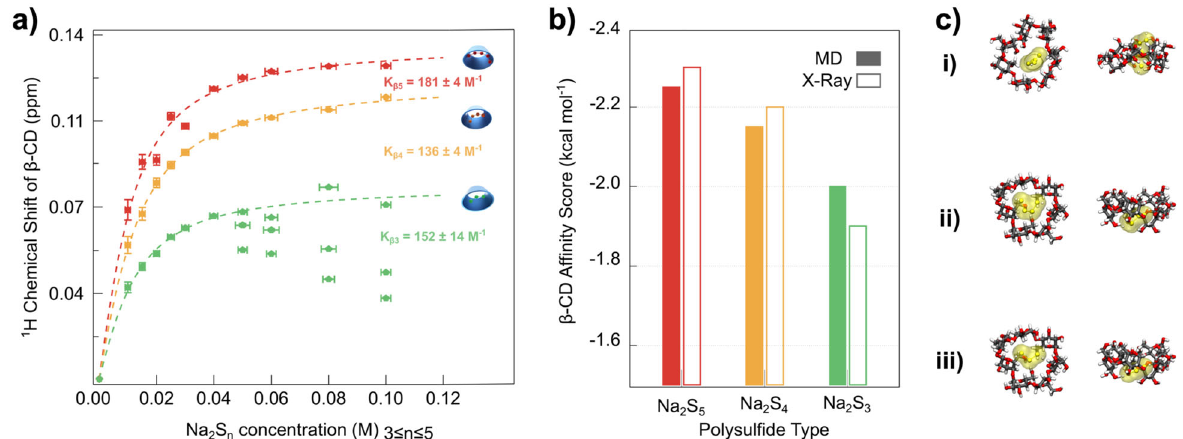
Fig. 3 In fl uence of polysul fi des chain length on β -cyclodextrin complexation. a Experimental binding isotherms for β -cyclodextrin complexes with Na 2 S 5 (red), Na 2 S 4 (orange), Na 2 S 3 (green), (See “ Methods ” section). The statistic error relative to the chemical shift measurement was obtained by the calculation of the standard deviation of 10 similar and independent points and is estimated to 9%. The plotted error bars were calculated considering the uncertainties propagation (see “ Methods ” section). b Best docking af fi nity scores (kcal mol − 1 ) over all the calculated β -cyclodextrin inclusion complexes with Na 2 S 5 (red), Na 2 S 4 (orange), and Na 2 S 3 (green). The fi rst set of calculations used the cyclodextrin structures extracted from PDB as receptors (empty bars) and the second set used the cyclodextrin structures generated by Molecular Dynamics simulations (full bars) (See “ Methods ” section and Supplementary Fig. 4). c Corresponding best docking poses for (i) Na 2 S 5 / β -cyclodextrin, (ii) Na 2 S 4 / β -cyclodextrin, and (iii) Na 2 S 3 / β -cyclodextrin complexes. Receptors structures are those obtained from Molecular Dynamics simulations, top and side view; β -cyclodextrin in sticks, polysul fi des in yellow space- fi ll representation, fi gure made with VMD 64 This observation is consistent with the similar trend obtained by with (S n ) 2 − inside the cyclodextrin cavity (Fig. 3c). The calculated calculations (Fig. 3b), performed by docking the different af fi nity scores increase with the length of the sul fi de chain and polysul fi des both on the cyclodextrin structures extracted thus con fi rm a weaker af fi nity for the Na 2 S 3 / β -cyclodextrin from the Protein Data Bank 46 (PDB) and on the ones generated complex, explaining the experimental noisy curve for this pair by Molecular Dynamics simulations, which may better represent (Fig. 3a, green points). Therefore, the results indicate a non- the cyclodextrin behavior in solution (Supplementary Figs. 7 and speci fi c complex formation but highlighted a polysul fi de ’ s size- 8). In all cases, the general trend is a (1:1) complex formation, dependent complexation towards β -cyclodextrin. Similar